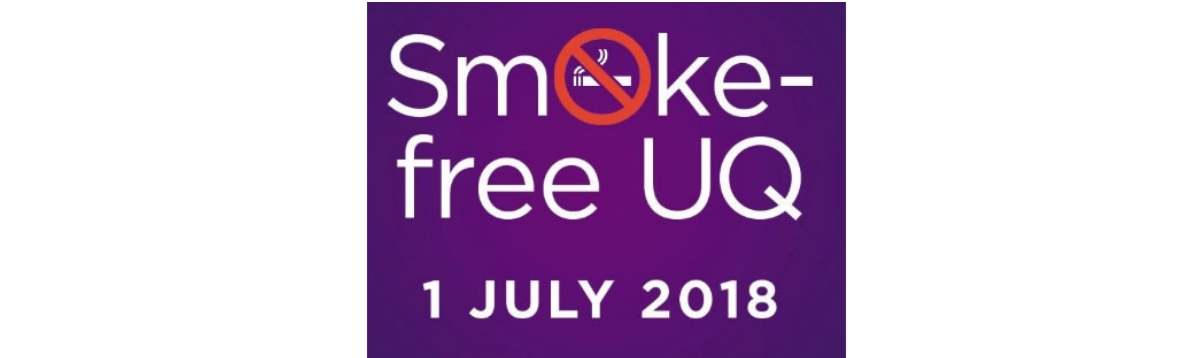
Figure 11. Example of a restrictive policy within the "regulation and advocacy"